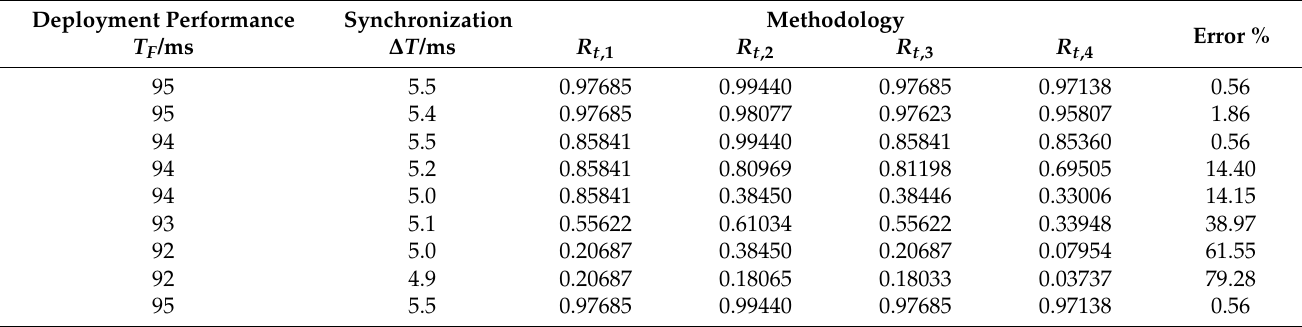
Table 4. Comparison of time